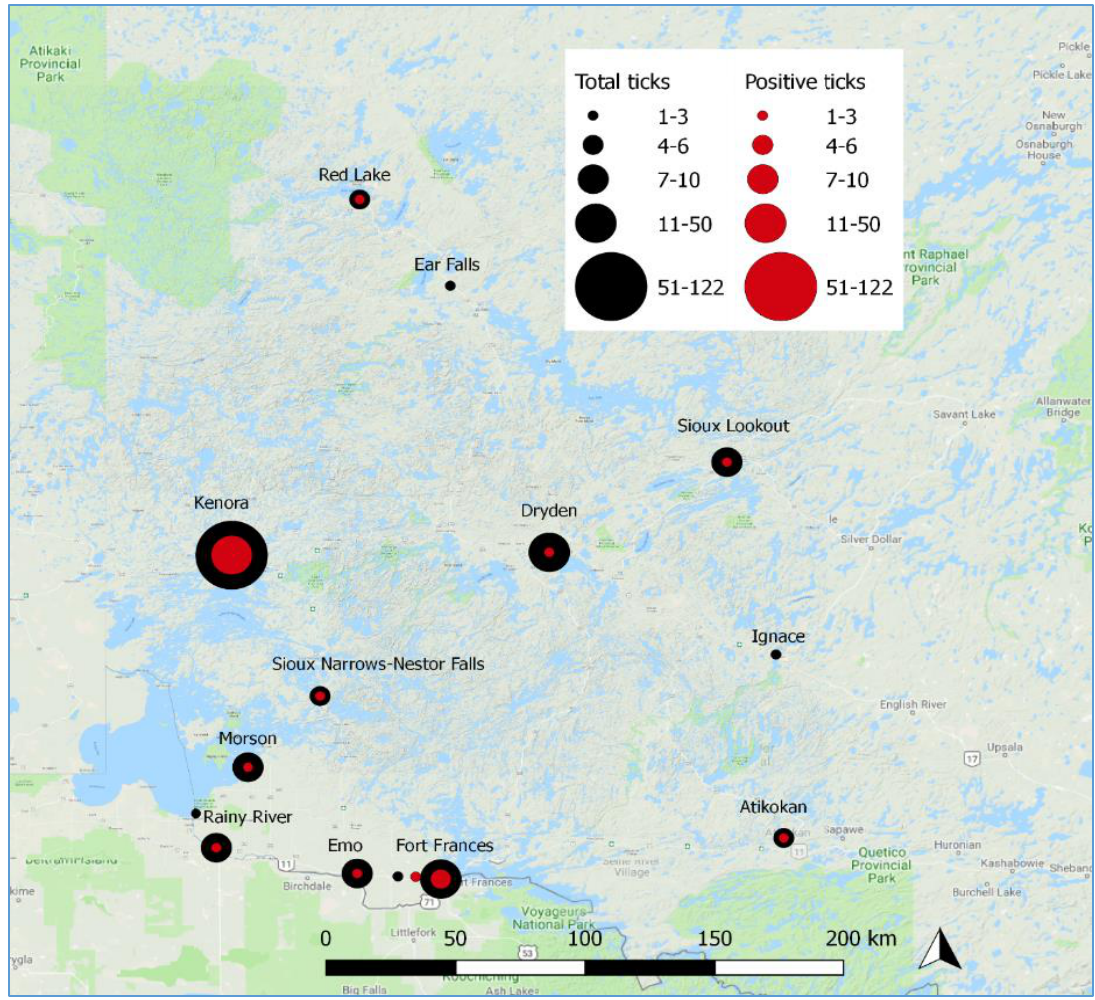
Figure 2. I. scapularis submissions through passive tick surveillance by B. burgdorferi -positivity in the NWHU catchment area from 2014 to 2017, by location of submission.